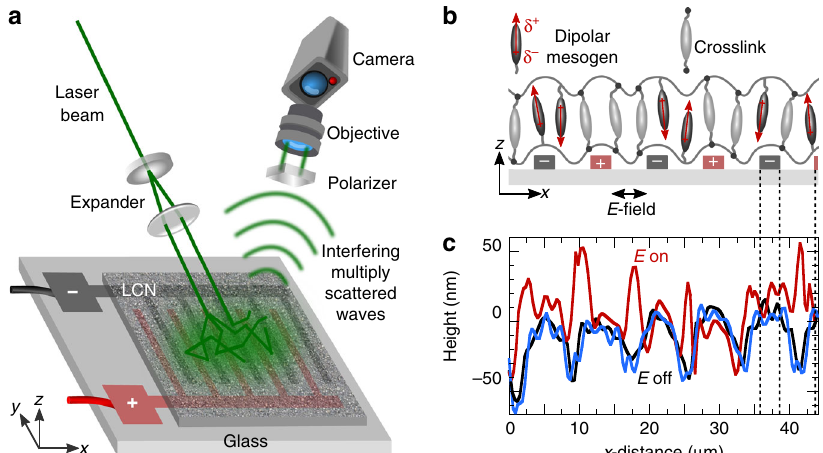
Fig. 1 Nanoscale imaging of surface strains. a Schematic illustration of a laser speckle imaging (LSI) experiment. Photons from coherent plane-wave illumination, impinging on a LC device, are backscattered by TiO 2 pigments on the surface, and detected by a high-speed camera. Motion of the surface results in fl uctuations in the detected speckle pattern, which we analyze to uncover the nanoscopic surface dynamics. b Schematic of the LC device prior to expansion (not to scale). Half of the mesogenic units (in dark grey) possess a permanent dipole moment which can be torqued by the fi eld, whereas the other half (in light grey) serve as crosslinkers. c Surface pro fi les measured by digital holography microscopy (DHM): initial fi eld-off state (black line), fi eld- on steady state (red line), and relaxed fi eld-off state (blue line). Switching turns the minima into maxima in a fully reversible